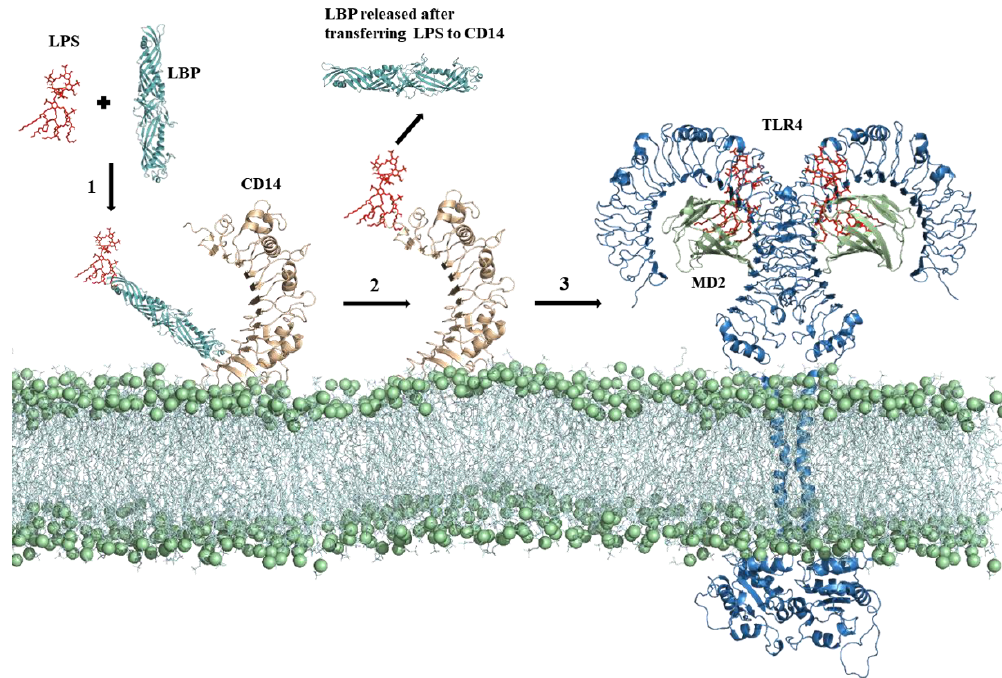
Figure 3. The binding mechanism of LPS for TLR4 activation. A series of events takes place prior to LPS recognition by the TLR4-MD2 complex. (1) LBP extracts LPS from the bacterial membrane and (2) transfers it to membrane anchored CD14, where it binds to the hydrophobic pocket located at the N terminus and forms a monomeric complex. (3) CD14 facilitates LPS transfer to the TLR4-MD2 complex where it initiated the intracellular pathway.